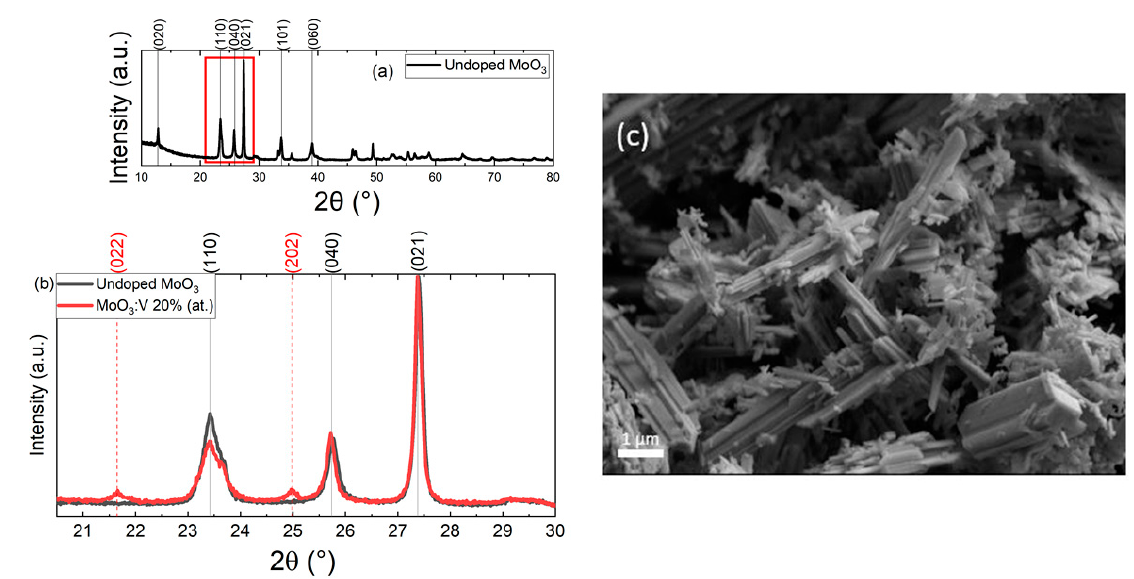
Figure 3. ( a ) P-XRD diffractogram of hydrothermally synthesized undoped MoO 3 . ( b ) Zoom on the 20.5°–30° 2 θ range of the same diffractogram and comparison with that of the MoO 3 :V 20% at. sample. ( c ) SEM image of a typical MoO 3 :V sample (20% at.) showing the micro-lamellar-like morphology.